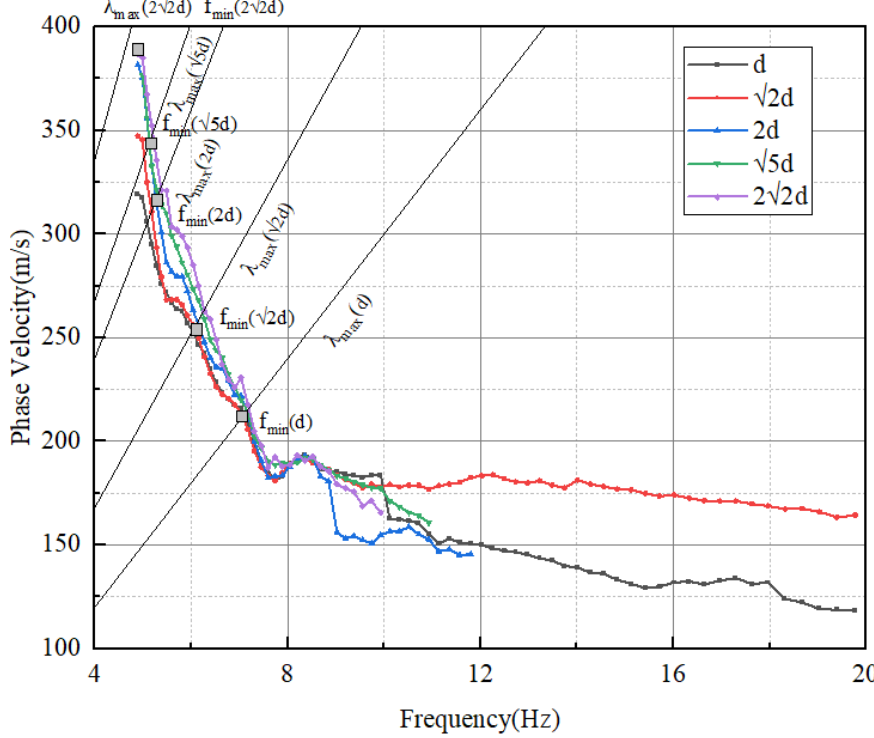
Figure 12. Maximum reliable low frequency of five -station distance combinations.